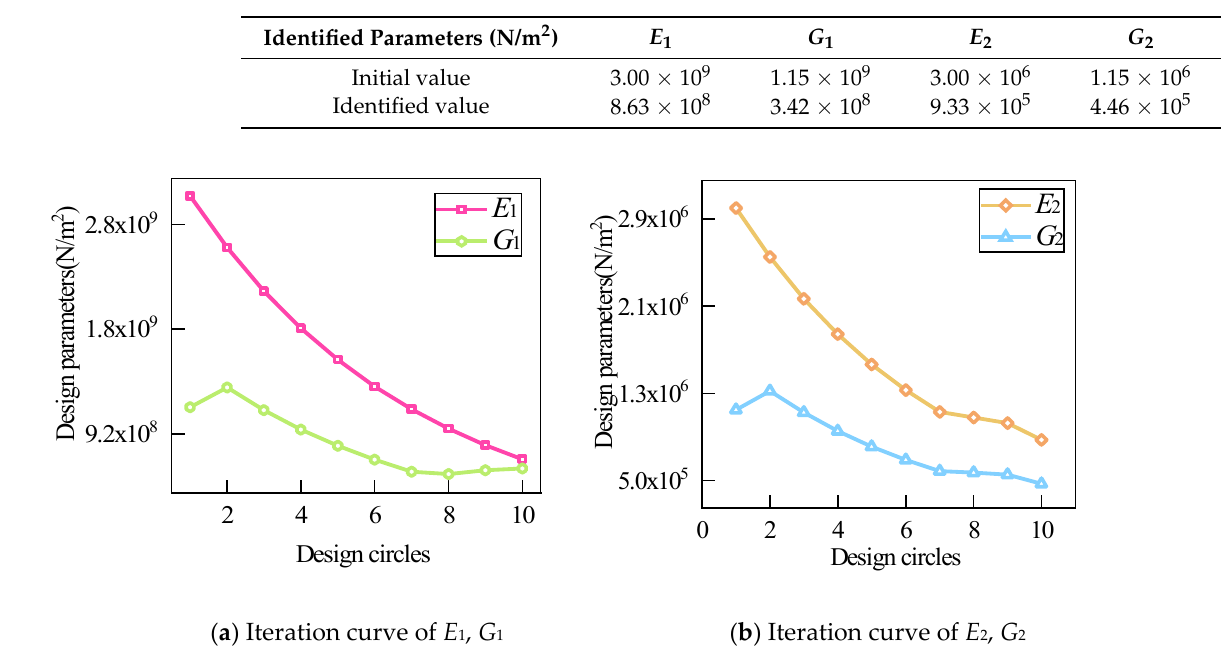
Figure 14. Iterative convergence curves of parameter selection. Table 6. Initial value of the identified parameters.